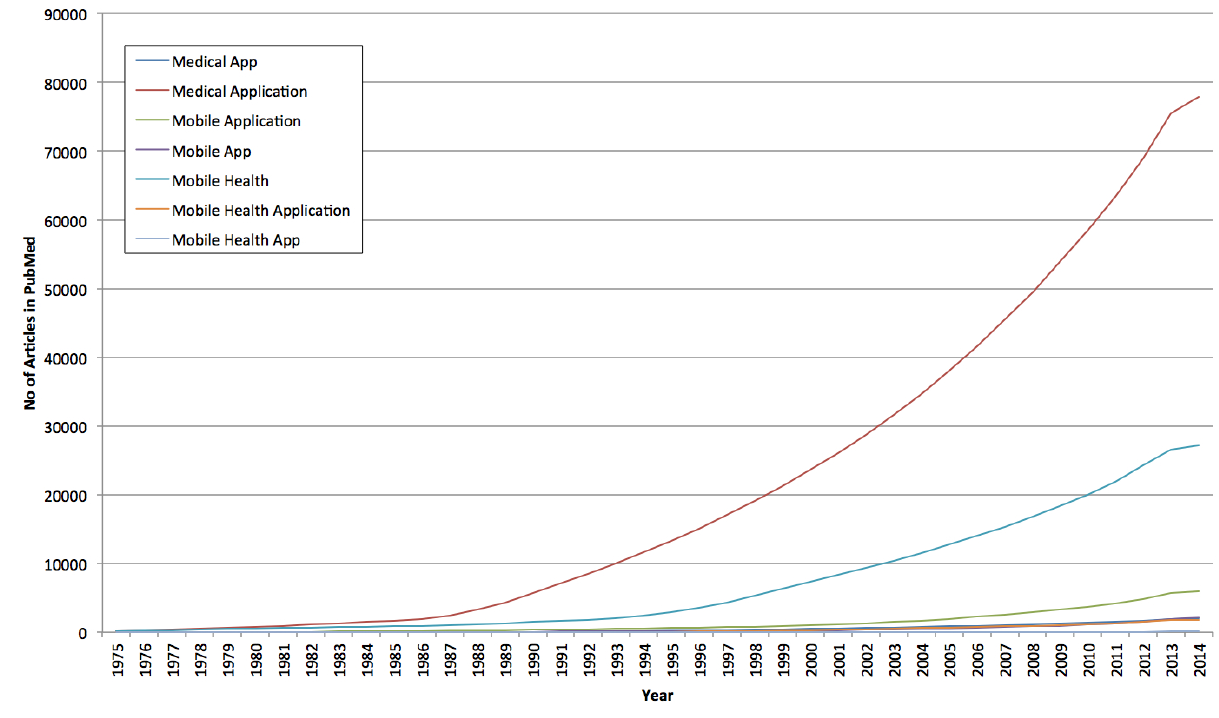
Figure 1. A graph showing cumulative number of PubMed search results by year since 1975 for keywords related to mobile applications (search carried out on April 7,